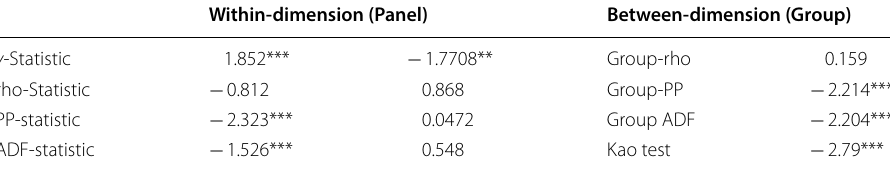
****, ** and * denote the significance at 1%, 5%, and 10%,